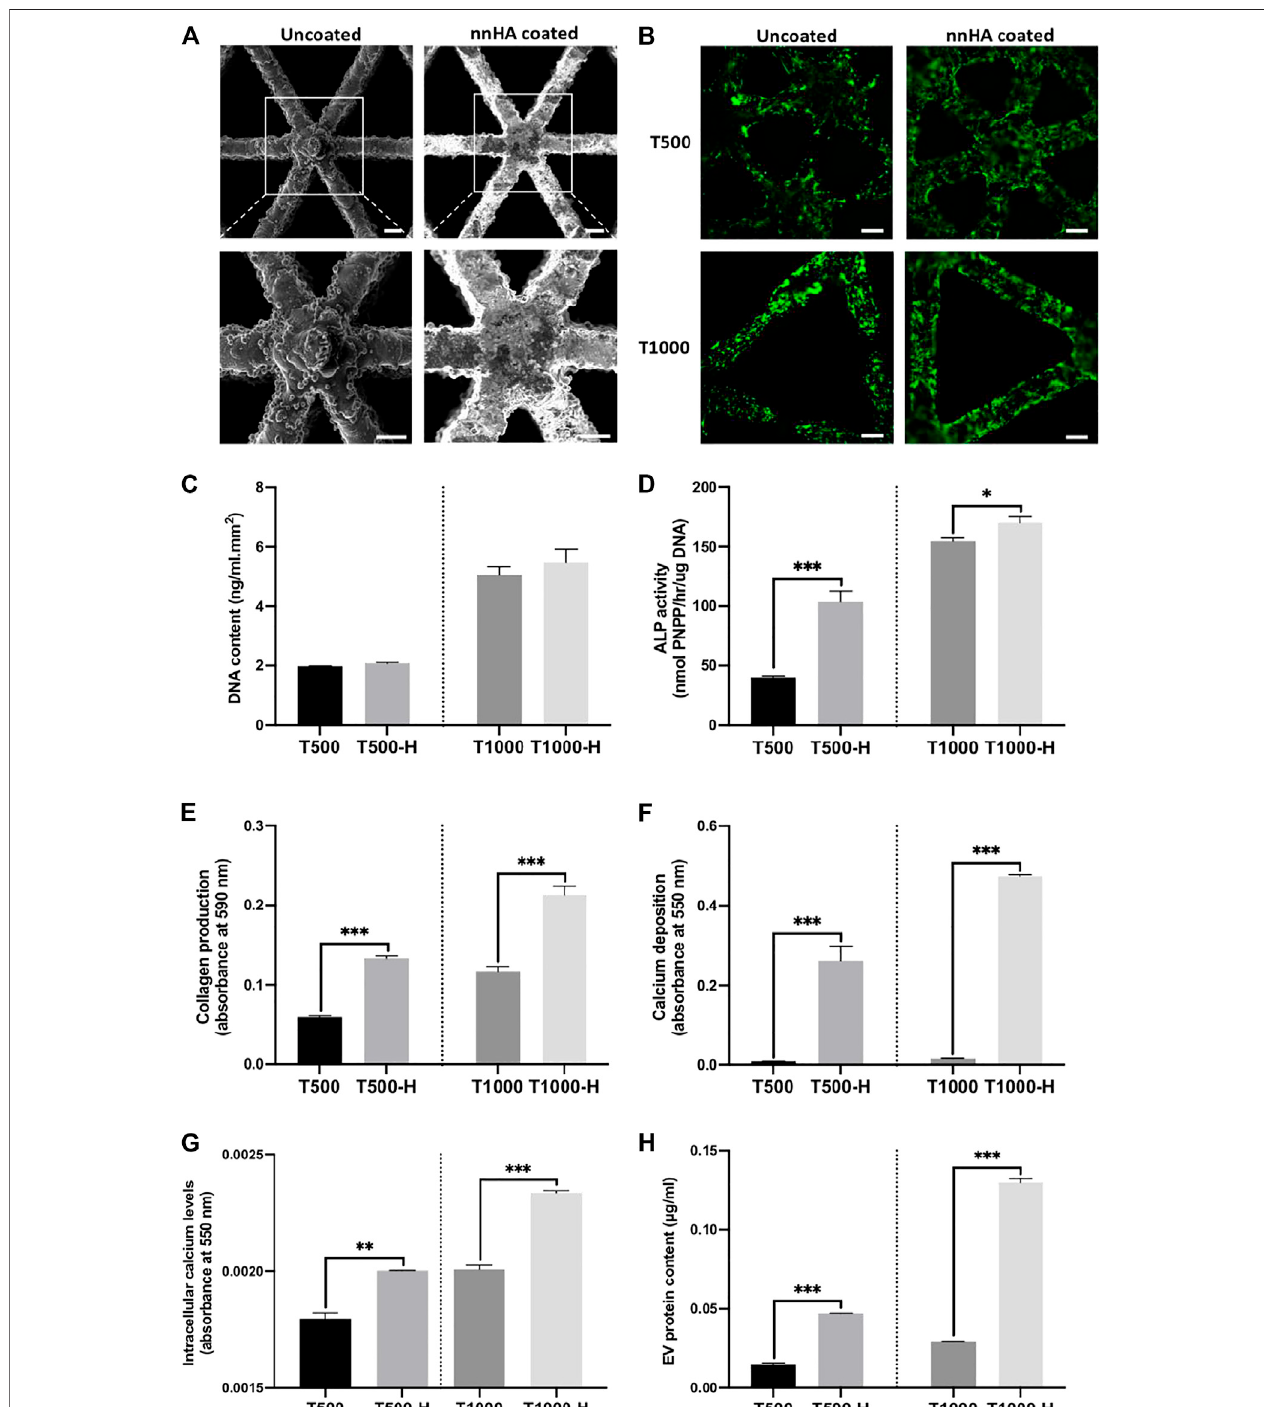
FIGURE 6 | The impact of nnHA coating on scaffold-cultured osteoblast mineralisation and EV production. (A) Representative SEM image of uncoated and nnHA coated titanium scaffold, scale bar (cid:2) 200 μ m, (B) live-dead staining of osteoblast following 24 h of culture, Scale bar (cid:2) 200 μ m, (C) proliferation, (D) ALP activity, (E) collagencontent, (F) calciumdeposition, (G) intracellularcalciumlevelsand (H) EVprocurementyield.Dataareexpressedasmean ± SD(n (cid:2) 3).*P ≤ 0.05,**P ≤ 0.01and ***P ≤ 0.001.